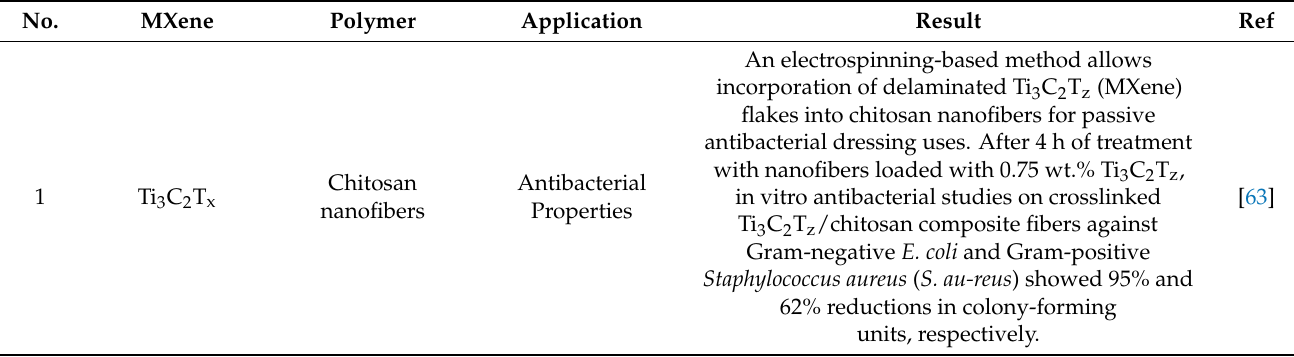
Table 4. MXene-encompassing